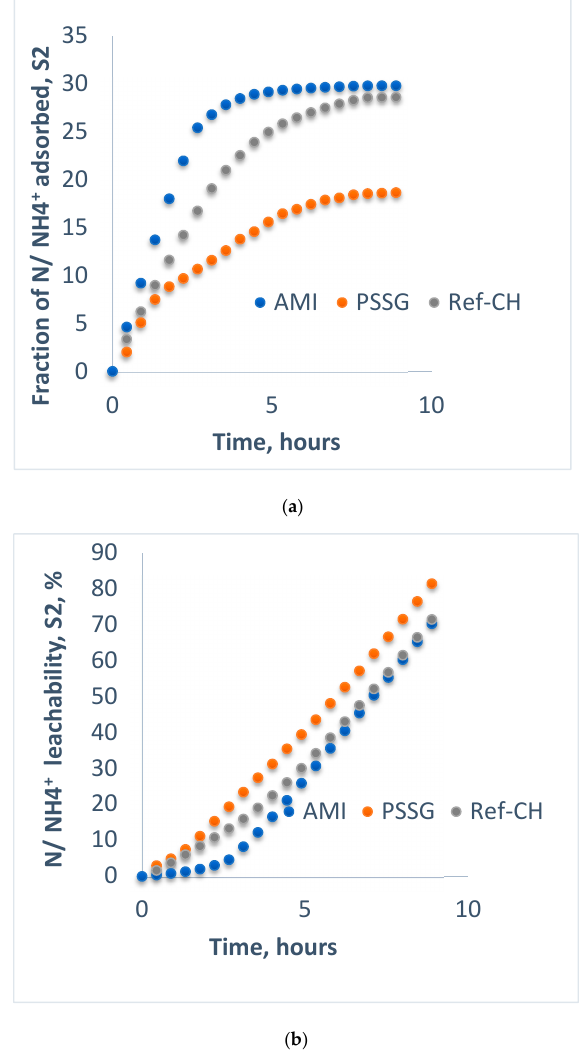
Figure 4. Fractions of phosphorus adsorbed ( a ) and leached ( b ) for the fertilizers on the mixture of sand and soil S2 ‐ CL.